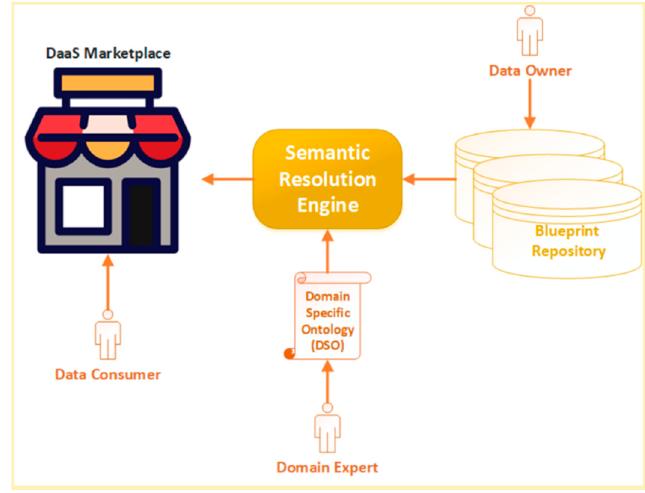
Figure 3. Semantic Resolution Engine architecture.